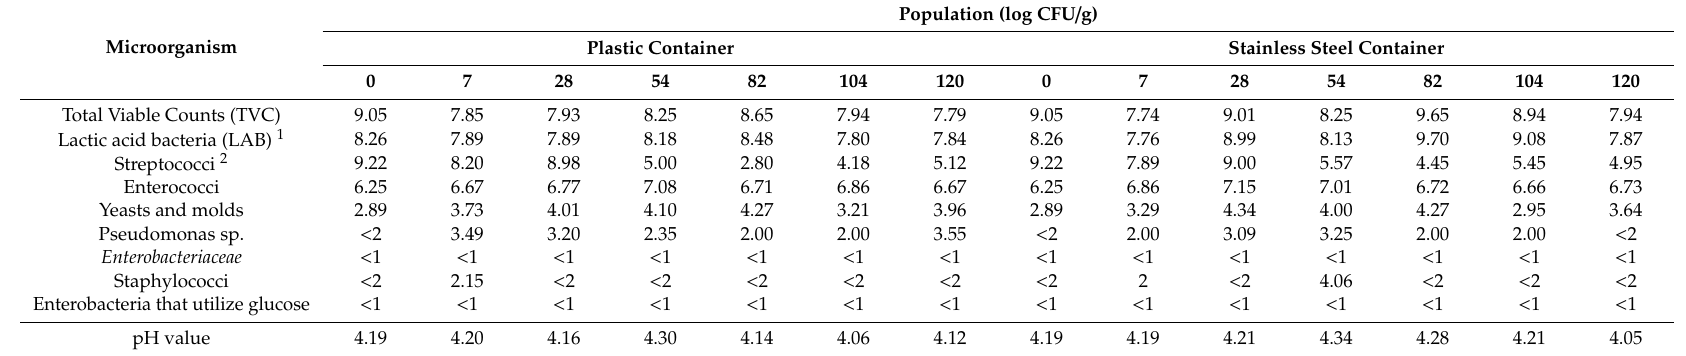
Enterobacteriaceae < 1 Staphylococci Enterobacteria that utilize